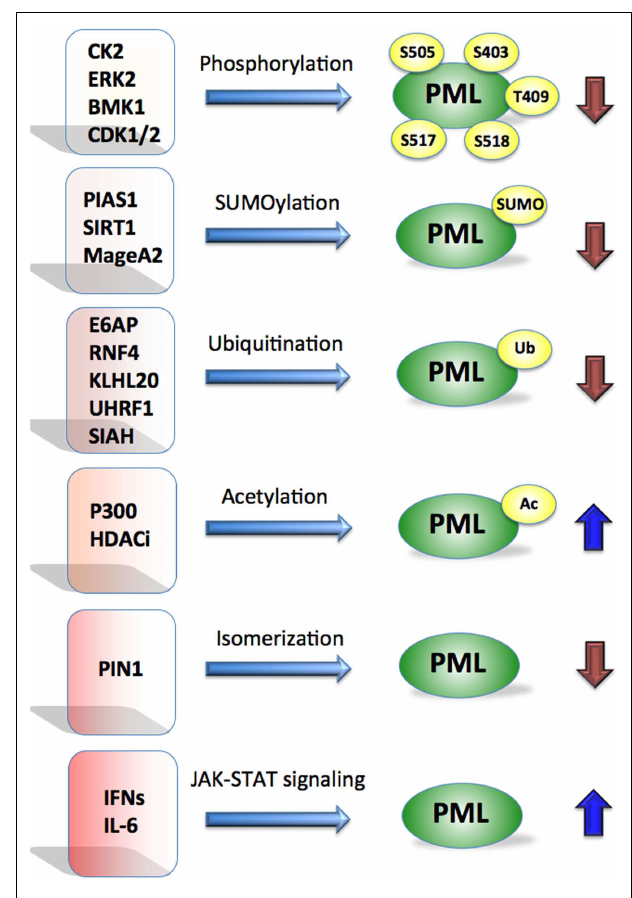
FIGURE 1 | Promyelocytic leukemia is regulated by multiple mechanisms . Post-translational modifications such as phosphorylation, SUMOylation, ubiquitination, acetylation, isomerization by indicated proteins affect PML stability. Cytokines such as IFNs and IL-6 are known to activate PML at the transcriptional level via JAK-STAT signaling. Blue arrows indicate positive and brown negative effect on PML.